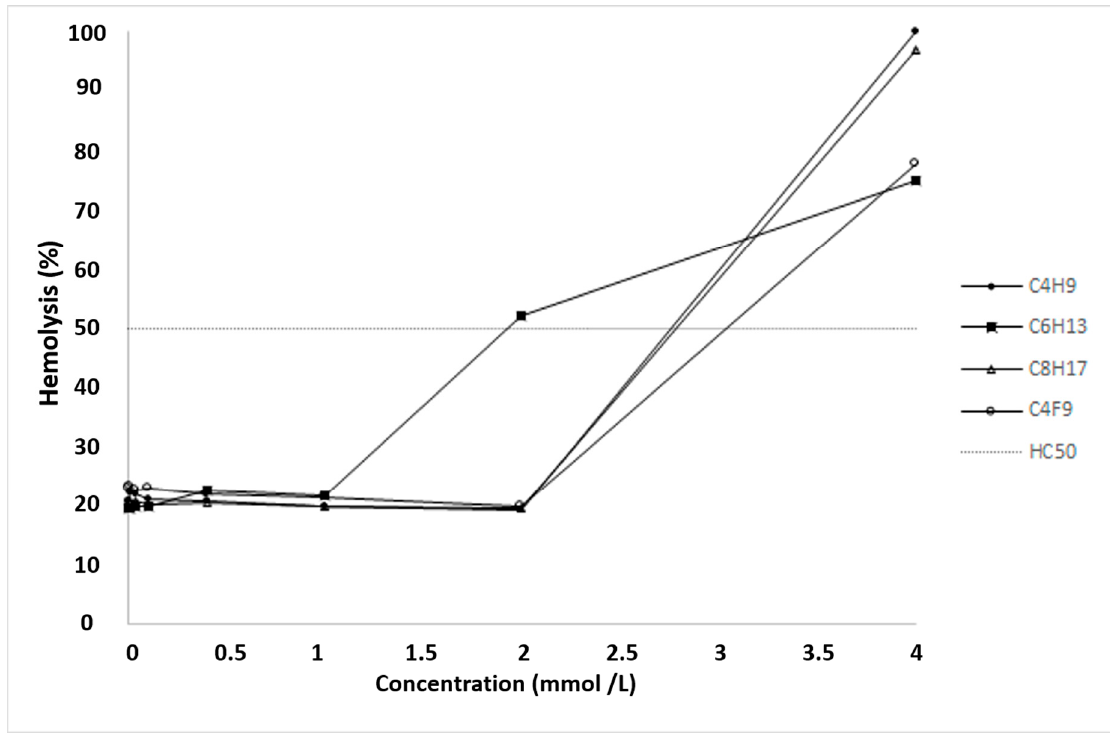
Figure 4. Hemolytic effect of different α‐ CD nanoparticles on human red blood cells (RBCs). Hemolysis was expressed as the percentage of the untreated control in the function of α‐ CD nanoparticle concentration. The positive control was purified water and the negative control was phosphate ‐ buffered saline (PBS). Values presented are means ± SD. All data were obtained from three independent replicates, and in the same experiment, two to four parallel concentrations were measured. HC 50 values were calculated as follows: C 6 H 13 = 1.93 ± 0.11 mmol ∙ L − 1 , C 4 H 9 = 2.59 ± 0.8 mmol ∙ L − 1 , C 8 H 17 = 2.79 ± 0.75 mmol ∙ L − 1 and C 4 F 9 = 3.04 ± 0.22 mmol ∙ L − 1 .